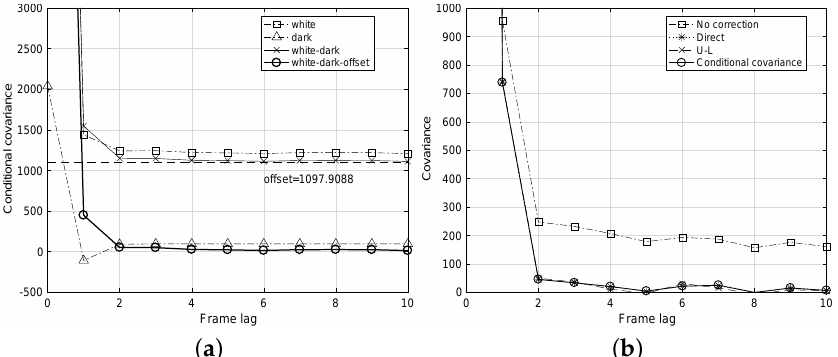
Figure 2. Estimated conditional covariances with respect to the frame lag (cid:96) . The frame rate was 10 fps, and the dose was 1809.5 nGy. ( a ) Conditional covariances of the white and dark images in the proposed conditional covariance algorithm; ( b ) Comparison of the NTG correction schemes and the proposed conditional covariance